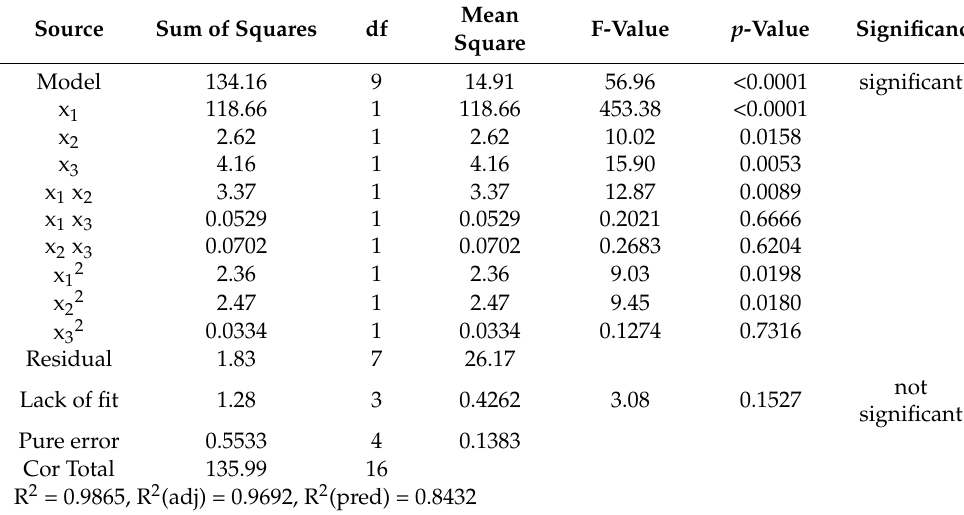
Table 7. Analysis of variance of the second-order